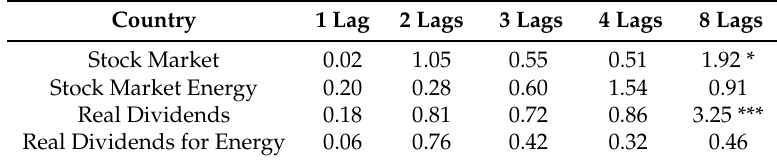
Table 3. Granger Causality tests: long-term interest